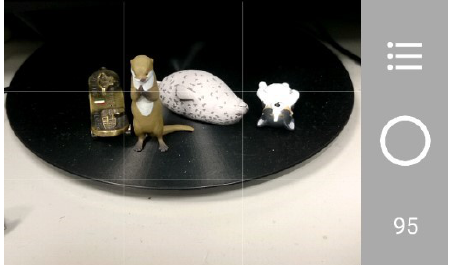
Figure 47. Results for the contrast composition method.